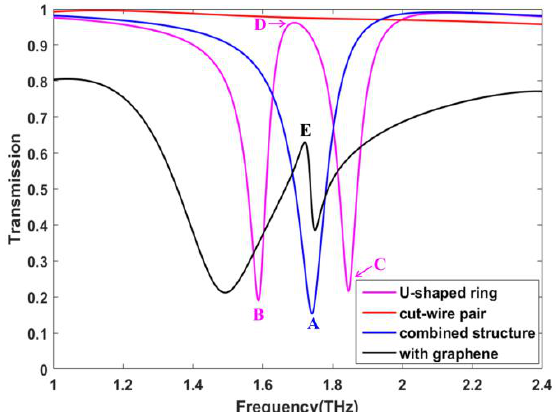
Figure 2. Transmission spectra of the sole U-shaped ring, the sole cut-wire pair, the combined structure, and the hybrid structure with a graphene layer.